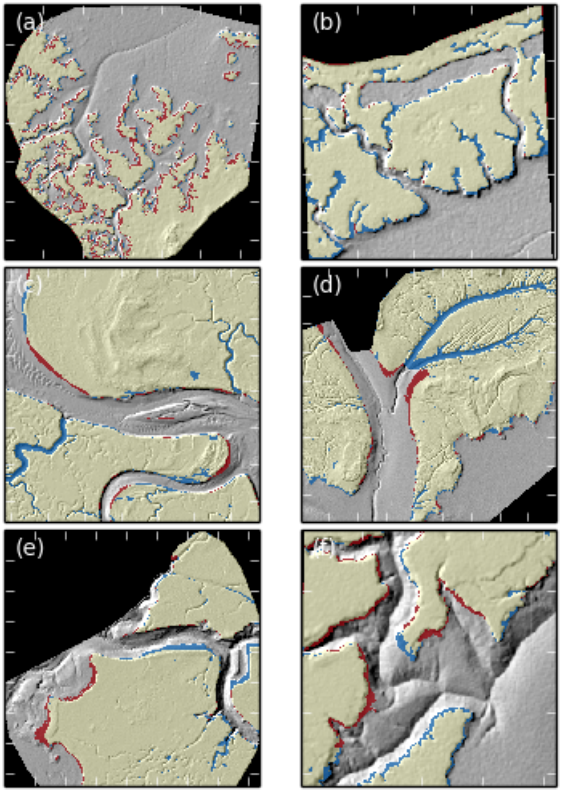
Figure 10. Rasters comparing digitised versus extracted marsh platforms superimposed on hillshade data for all six sites after de- tection with no Wiener filtering. Black areas are outside of the de- tection domain and contain no data. Yellow areas correspond to true positives (TPs) and transparent areas to true negatives (TNs). Red areas correspond to false positives (FPs) and blue areas to false negatives (FNs). Ticks are placed 50m apart. The sites are num- bered as follows: (a) Shell Bay, Dorset; (b) Stour Estuary, Suffolk; (c) Stiffkey, Norfolk; (d) Medway Estuary, Kent; (e) Jenny Brown’s Point, Lancashire; (f) Parrett Estuary,